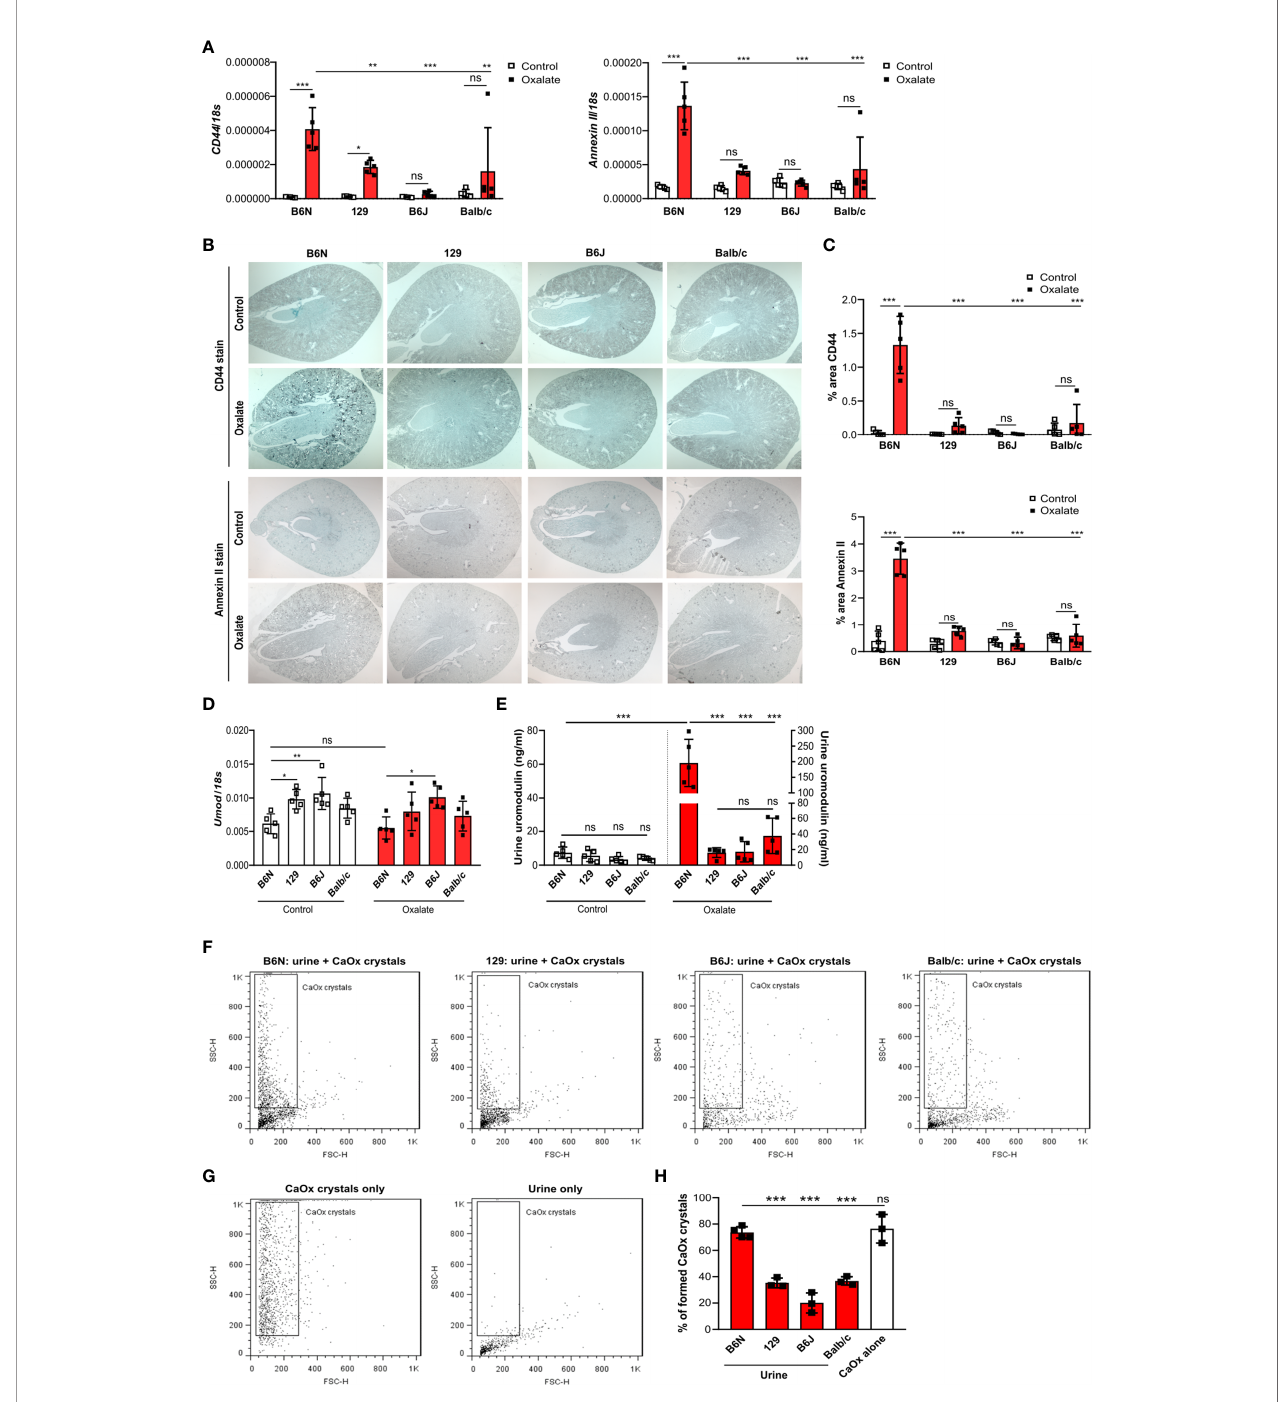
FIGURE 3 | Increased urinary uromodulin excretion in B6N mice due to CaOx crystal deposition. (A – E) B6N, 129, B6J and Balb/c mice were either placed on a control diet or an oxalate-rich diet for 14 days. (A) Intrarenal mRNA expression of CD44 and Annexin II determined by RT-PCR. (B, C) Immunostaining for CD44 and annexin II in kidney sections (B) and quanti fi cation of the percent (%) area (C) . Original magni fi cation ×25. (D) Intrarenal mRNA expression of Umod in kidney tissues by RT-PCR. (E) Uromodulin concentration in urine measured by ELISA. Data are mean ± SD from 5 mice in each group. *p < 0.05; **p < 0.01; ***p < 0.001; ns, not signi fi cant. (F – H) CaOx crystallization assays in vitro . Urine from healthy B6N, 129, B6J and Balb/c mice was pre-incubated with or without 100 µl of a Na 2 C 2 O 4 solution (oxalate, 0.1 mM, pH 7.3) for 1 hour at room temperature and then incubated with 100 µl CaCl 2 buffer (0.1 mM, pH 7.3) for 5 minutes. Representative images of gating strategy to identify CaOx crystal formation in the presence or absence of mouse urine (F, G) and quanti fi cation of CaOx crystals by size ( H , forward scatter vs. sideward scatter) using fl ow cytometry analysis. Data are mean ± SD from 3 mice per group. ***p < 0.001; ns indicates not signi fi